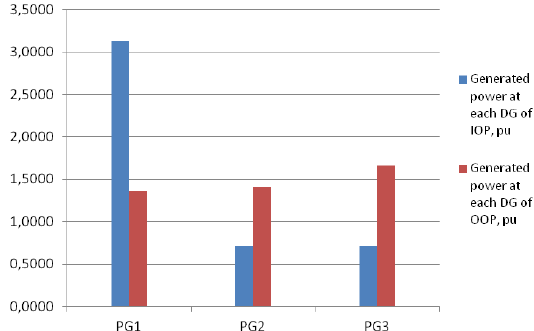
Figure 7. Generated power change at each DG